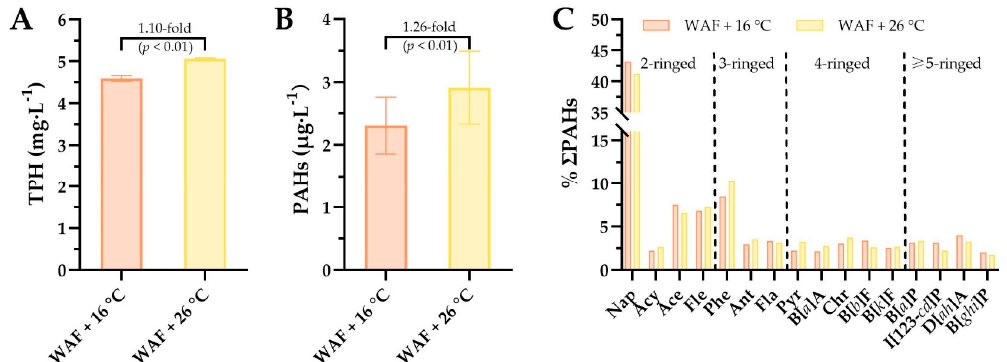
Figure 2. The concentrations of total petroleum hydrocarbons (TPH, ( A )), the levels of US EPA’s 16 priority polycyclic aromatic hydrocarbons ( Σ PAHs, ( B )), and the proportion (%) of each PAH ( C ) in the water ‐ accommodated fractions (WAF) of Oman crude oil at an optimal temperature of 16 °C (WAF + 16 °C, light ‐ red filled) and Oman crude oil WAF at an elevated temperature of 26 °C (WAF + 26 °C, light ‐ yellow filled) solutions. Nap: Naphthalene, Acy: Acenaphthylene, Ace: Acenaphthene, Fle: Fluorene, Phe: Phenanthrene, Ant: Anthracene, Fla: Fluoranthene, Pyr: Pyrene, B[ a ]A: Benzo[ a ]anthracene, Chr: Chrysene, B[ b ]F: Benzo[ b ]fuoranthene, B[ k ]F: Benzo[ k ]fuoranthene, B[ a ]P: Benzo[ a ]pyrene, I[123 ‐ cd ]P: Indeno[1,2,3 ‐ cd ]pyrene, D[ ah ]A: Dibenzo[ a , h ]anthracene, and B[ ghi ]P: Benzo[ g , h , i ]perylene.